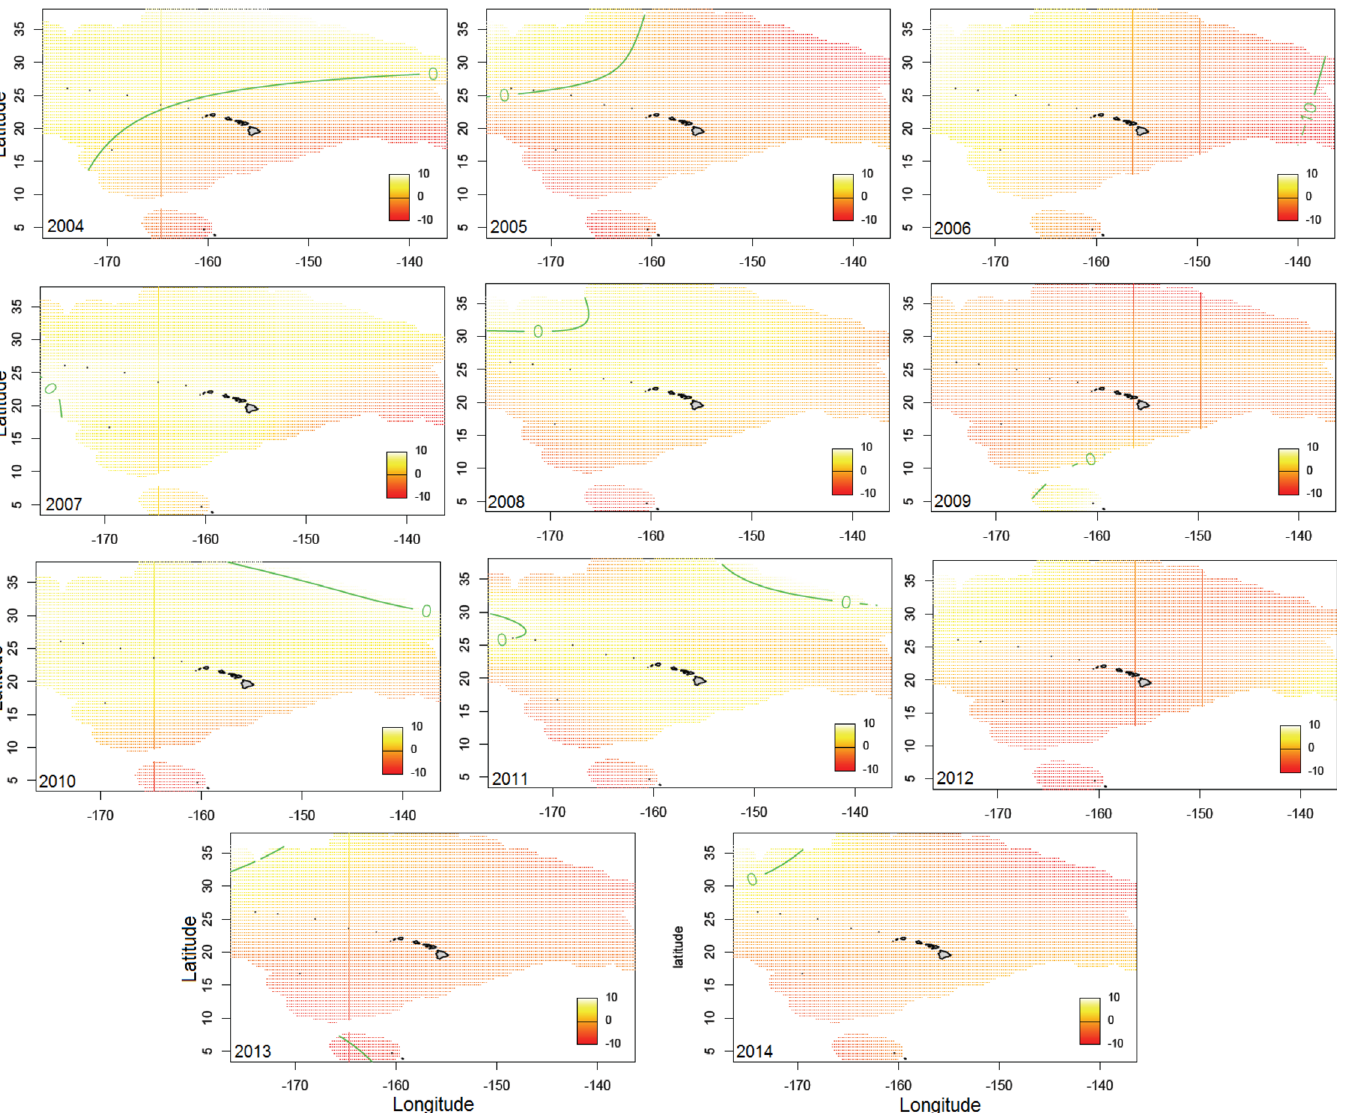
Fig 2. Spatio-temporal effect. Structured spatial effect for each of 11 years (2004 – 2014), Hawaii longline tuna fishery. Color scale units represent centered scale values as for GAMM response variables shown in Fig